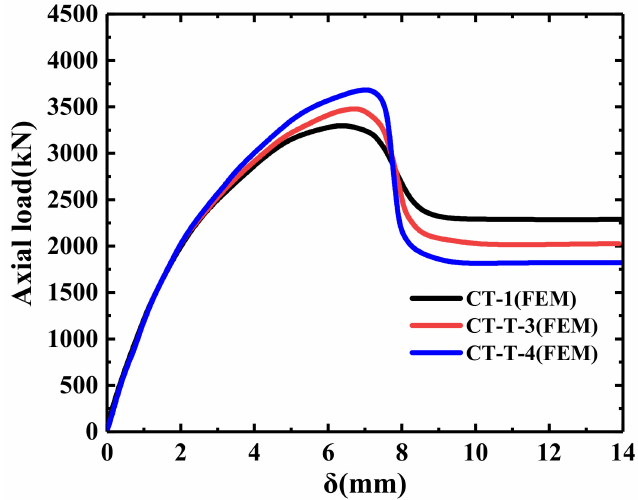
Figure 20. Load–displacement curves for different concrete strengths.